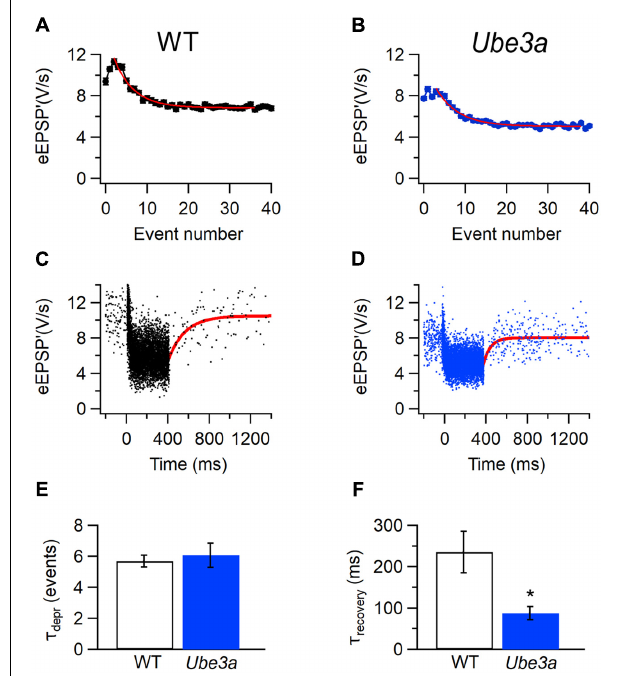
FIGURE 13 | Faster kinetics of recovery from STD in Ube3a mice. (A) Amplitude of eEPSP’ against sound-evoked event number from recording of C57BL/6J WT cell. Error bars indicate SEM. Solid line is fit with single exponential function. (C) Sound-evoked eEPSP’ in a WT animal. Solid line is fit of recovery from sound-evoked STD with single exponential function with time constant 215 ms. (B,D) Both are similar with A and C , respectively, except that the recording was from a Ube3a mouse 31 ms. (E) Comparison of results of fit of depression time course as shown in A and B for WT and Ube3a animal. (F) Comparison of recovery time constants as shown in C and D for WT and Ube3a . A and C are from the same WT recording; B and D are from the same unit of a Ube3a mouse. ∗ Indicates p <